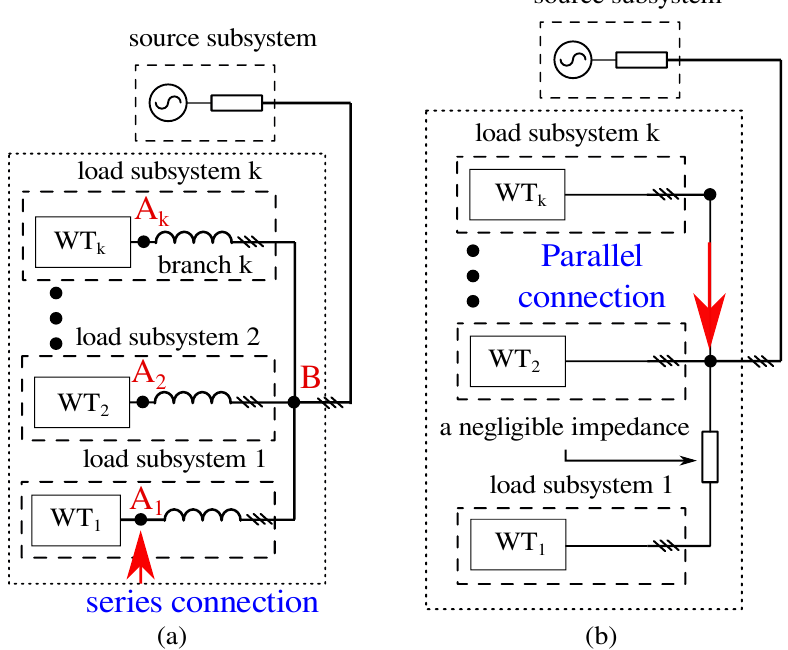
Figure 2. ( a ) Series connection of the impedance model; ( b ) Parallel connection of the impedance